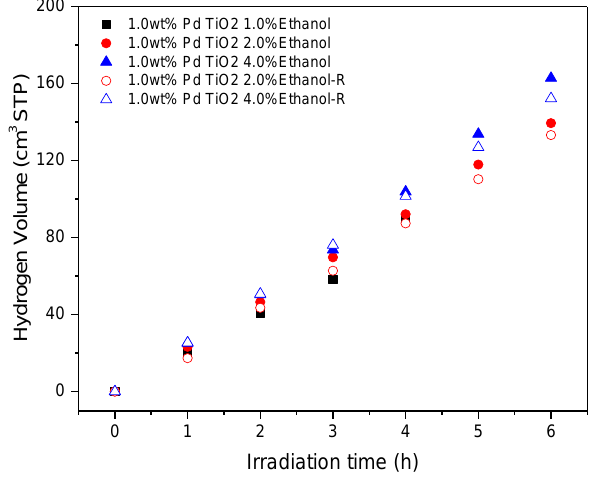
Figure 9. Hydrogen volume using 1.00 wt% Pd at 1.0, 2.0 and 4.0 v/v% ethanol. Conditions: photocatalyst concentration 0.15 g/L, argon atmosphere, pH = 4 ± 0.05 and near-UV light, R = repeat. Standard deviation: ±6.5%.